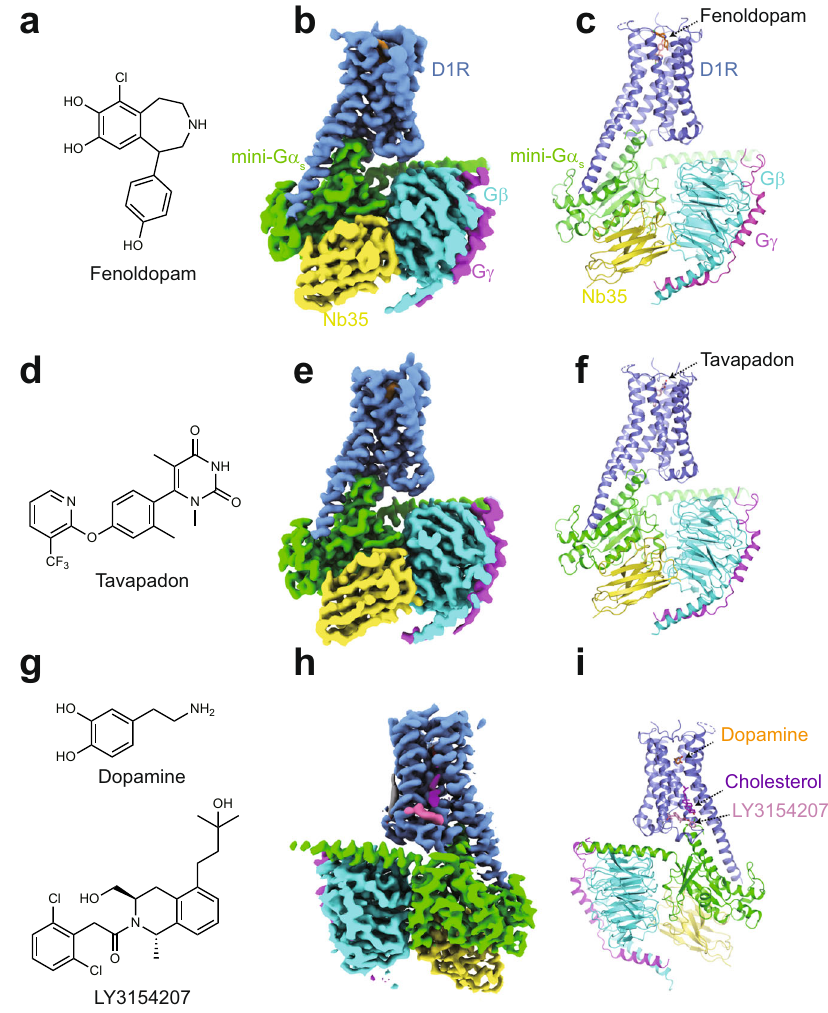
Fig. 1 Overall structures of the D1R-mini-Gs-Nb35 complexes. a – c Structure of the fenoldopam-bound D1R complex. a Chemical structure of fenoldopam. b Cryo-EM map of the complex. c Ribbon representations of the structure. D1R, mini-G α s , G β , G γ , and Nb35 are colored in blue, green, cyan, magenta, and yellow, respectively. d – f Structure of the tavapadon-bound D1R complex. g – i Structure of the dopamine-LY3154207-bound D1R